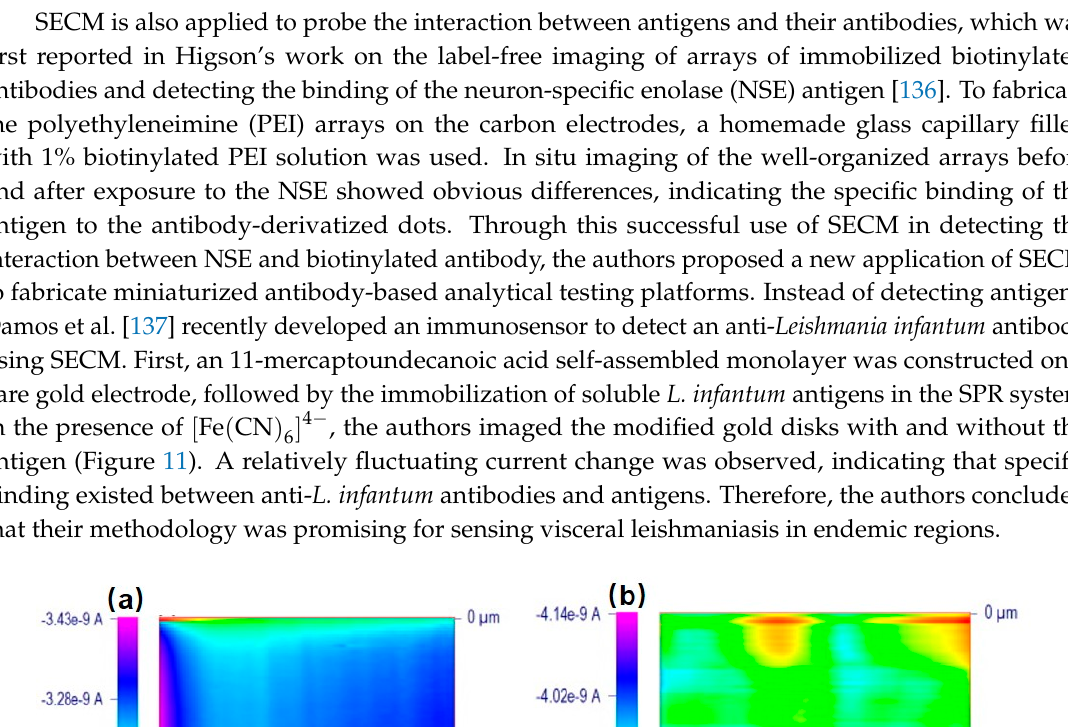
Figure 10. ( a ) Schematic illustration of constant-height feedback mode SECM imaging with a living cell in the presence of FcCH 2 OH as a redox mediator; ( b ) Normalized SECM current recorded at a distance of 12 µ m above the substrate when HeLa cells were exposed to FcCH 2 OH (1 mM) for 75 min. (Inset) Close-up three-dimensional (3D) view of the signal obtained from an individual cell island. Copyright (2013) National Academy of Sciences.